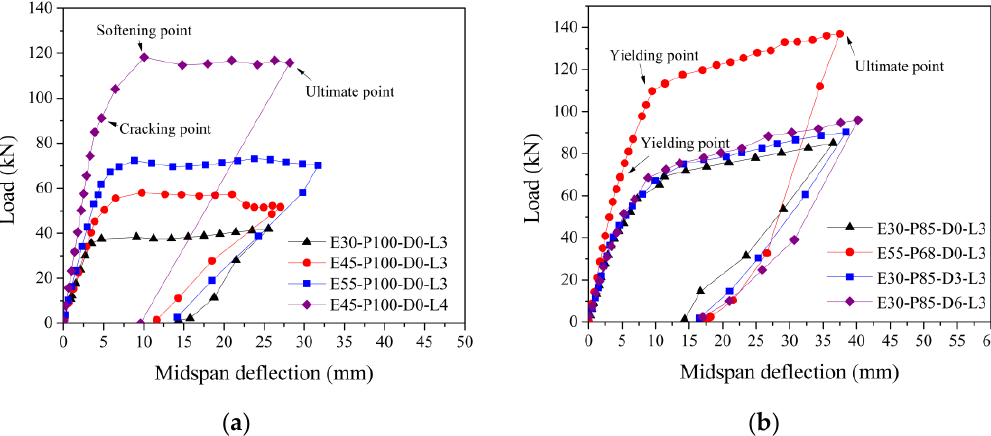
Figure 6. Load-deflection relationships of specimens: ( a ) the fully prestressed specimens; ( b ) the partially prestressed specimens.